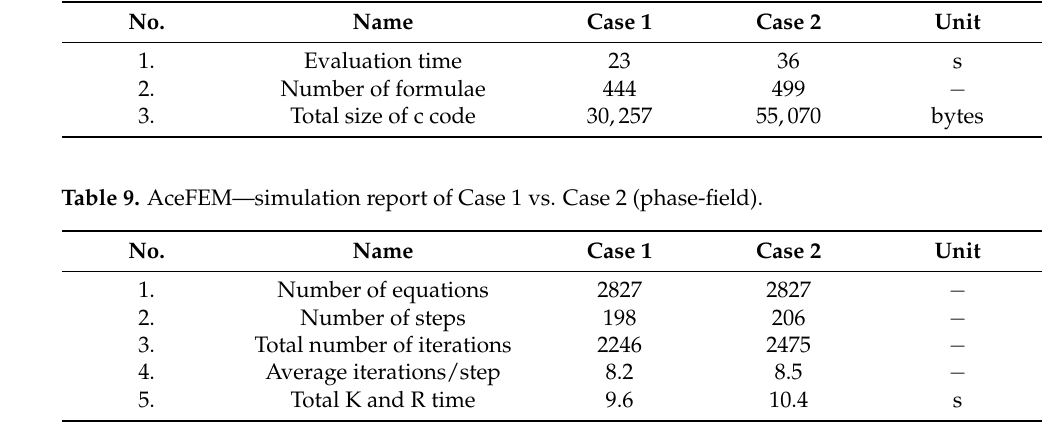
Table 8. AceGen—Case 1 vs. Case 2 (Phase-field).